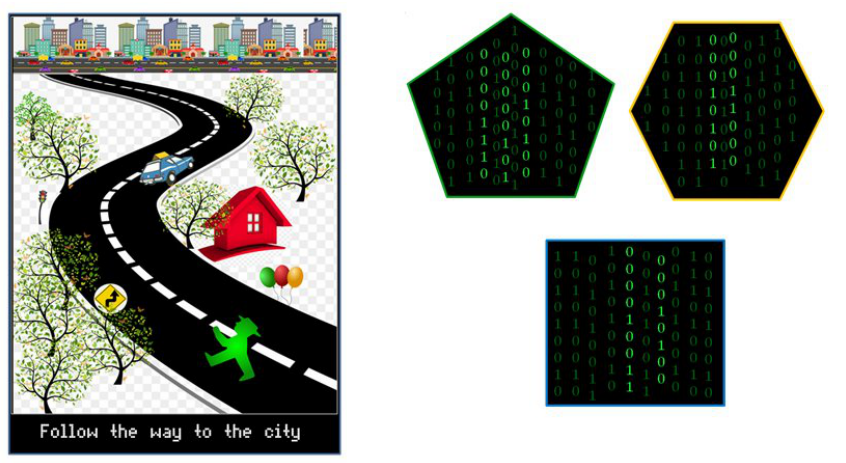
Figure 6. Green man riddle and Matrix